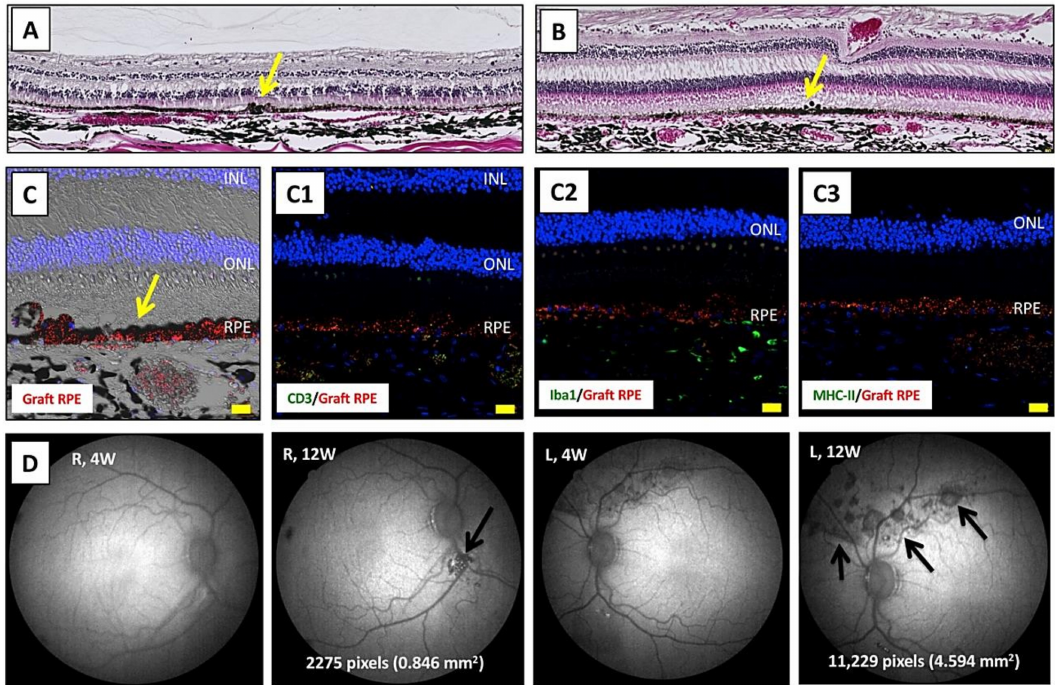
Figure 6. Graft survival, expanded graft cells, and no inflammation in Y-27632 RPE cell-transplanted retinas. ( A ) H&E staining shows RPE cell graft survival in the right eye, but grafted cells look like clumps (yellow arrow). ( B ) In contrast, in the left eye (Y-27632 RPE cell transplantation), there was RPE cell graft survival and expanded iPS-RPE cells in the subretinal space. The expanded RPE cells became sheetlike (yellow arrow). ( C ) Confocal microscopy of IHC shows PKH-labeled RPE cells (graft RPE, red) through the retinal sections of the left eye. Unlike an immune-reactive retina, there were no CD3 + T cells ( C1 , green), few Iba1 + microglia/macrophages ( C2 , green), and no MHC-II + antigen-presenting cells ( C3 , green) invading the retina and choroid throughout the sections, and there was graft survival of transplanted RPE cells (red). INL, inner nuclear layer; ONL, outer nuclear layer; RPE, retinal pigment epithelium. Scale bar = 20 µ m. ( D ) AF images show a dark area that corresponds to the grafted RPE cells after transplantation (arrows). Compared with transplantation without Y-27632 (right eye), the cell graft area was 5-fold greater with Y-27632 (left